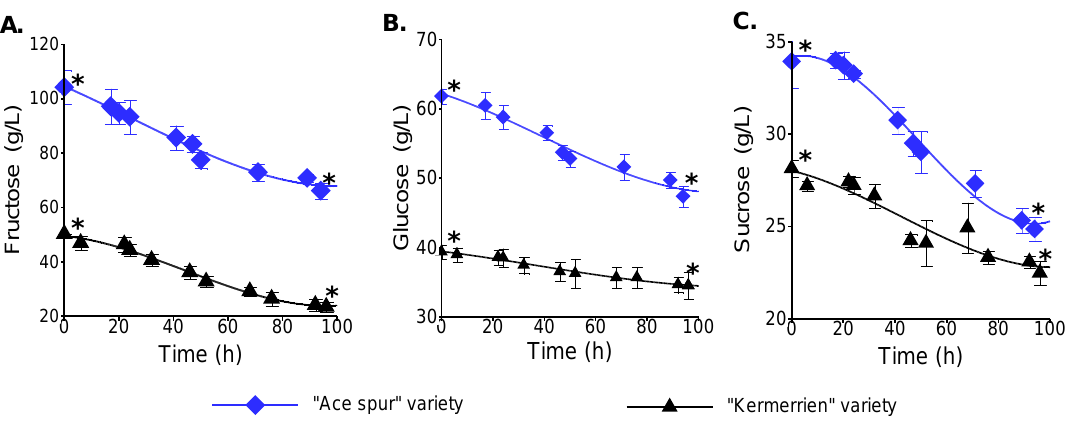
Figure 5. Evolution of the fermentative sugars (fructose ( A ), glucose ( B ), sucrose ( C )) during the fermentation of the juice obtained from the “Ace Spur” and “Kermerrien” varieties. “*” denotes significant differences between the initial concentrations of the juice and after 100 h of fermentation.